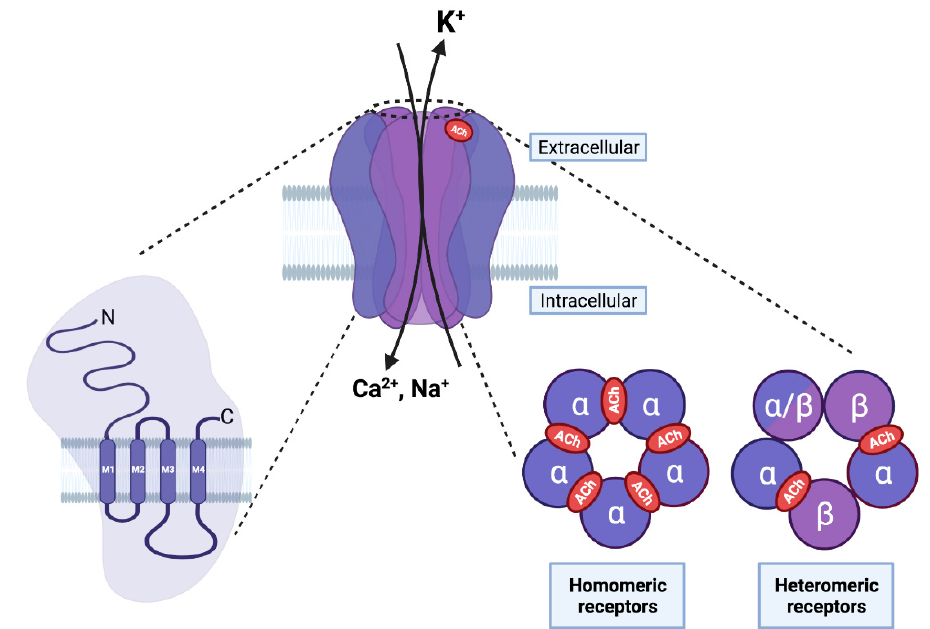
Figure 2. Structure of nAChRs. On the left, each nAChR subunit is composed of an extracellular amino terminal portion, followed by three hydrophobic transmembrane domains (M1–M3), a large intracellular loop, a fourth transmembrane domain (M4), and an extracellular carboxy–terminus. In the middle, the pentameric arrangement of nAChR subunits is shown in an assembled receptor. The M2 transmembrane domain of the five subunits forms the central pore and possesses amino acids that are important for ion selectivity, permeability, and channel gating. On the right, five subunits can assemble to form homo- (five α subunits) or hetero-pentameric ( α and β subunits) receptors. The orthosteric ligand binding site is formed between two α subunits (in red) in homomeric receptors, and between the α and β subunits in an heteromeric receptor. (Created with BioRender.com (accessed on 12 March 2022)).